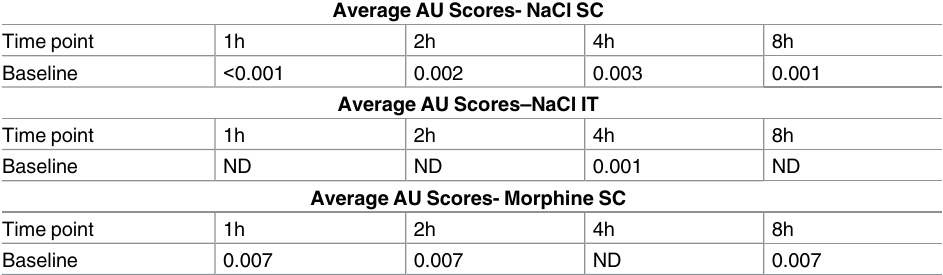
Table 4. Within-subjects comparison between post treatment time-points with baseline with associ- ated p -values for differences where significance was found (phase 1 of the study). Differencesare sig- nificant if p < 0.05. AU: Action Unit; SC: Subcutaneous; IT: Intrathecal; ND: No significant